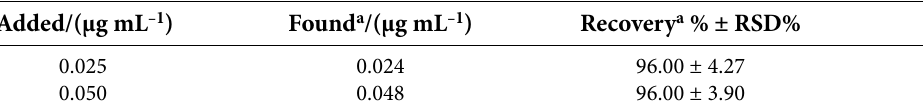
Table 3. The results for addition and recovery of pantoprazole from urine sample using SW-AdSV. Added/(µg mL – 1